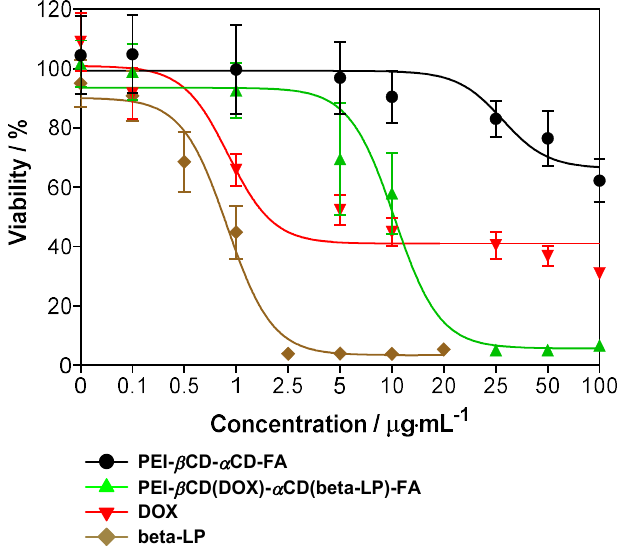
Figure 8. The viability of A549 cells treated with nanoconjugate transporters loaded with and without doxorubicin and beta-lapachone and free doxorubicin and beta-lapachone for 24 h. Data are mean ± SD from three independent experiments.